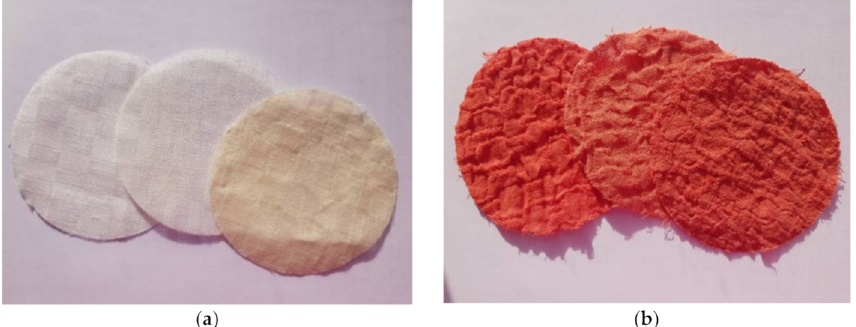
Figure 4. ( a ) Grey fabrics (flax, hemp, flax/silk), and ( b ) finished fabrics (flax, hemp,